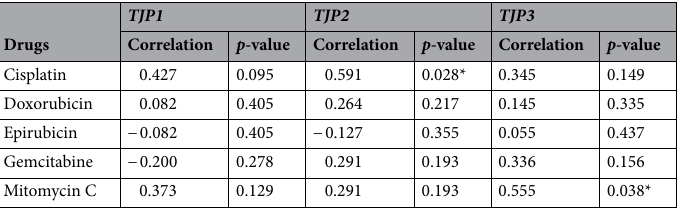
Table 2. Correlation of TJP family expression with chemotherapy drugs in bladder cancer cell lines. * p values <0.05 were considered statistically significant.